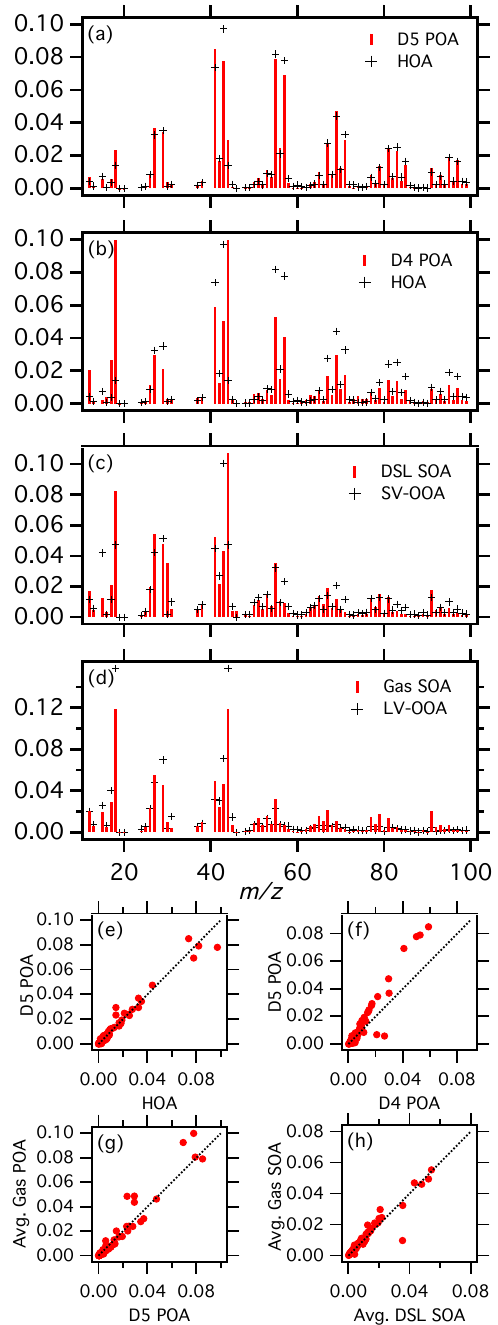
Figure 5. Mass spectra of POA emissions from vehicles D5 (a) and D4 (b) are shown and compared to ambient HOA. The average diesel SOA factor mass spectrum (c) is compared to the average am- bient SV-OOA mass spectrum, and the average gasoline SOA (d) is compared to ambient LV-OOA. The scatter plots in (e)–(h) provide further comparisons of the mass spectra in (a)–(d) . The dashed lines in (e)–(h) are the 1 : 1